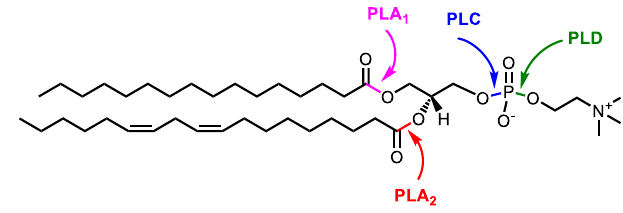
Figure 2. Enzymes acting on phosphatidylcholine (here reported as 1-palmitoyl-2-linoleoyl- phosphatidylcholine) and their specific site of